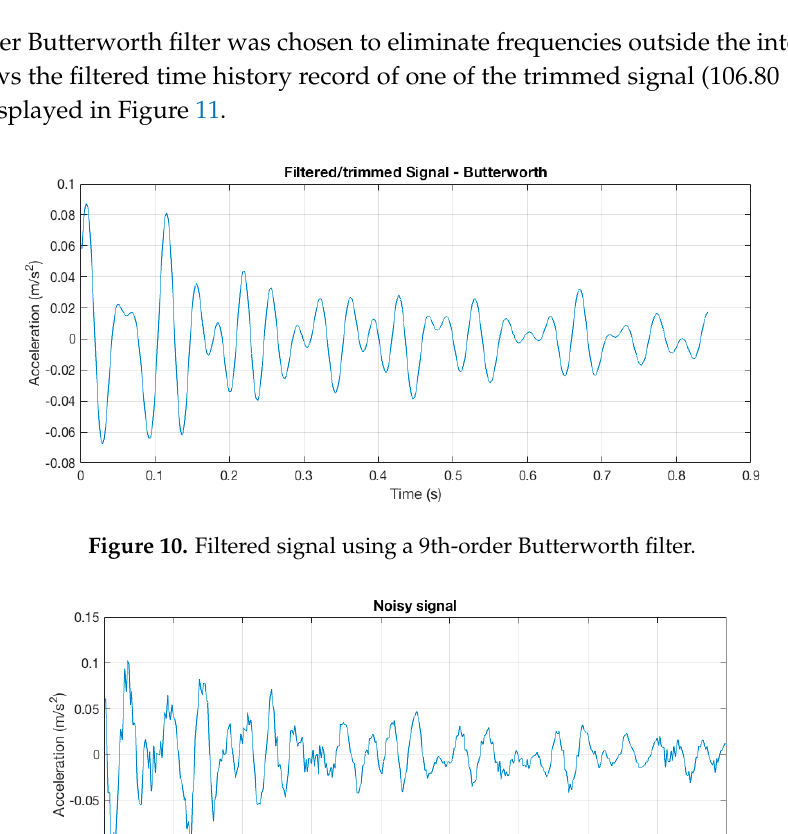
Figure 11. Trimmed signal, T = 0.9 s, test #2, accelerometer #1 (column mid-height).